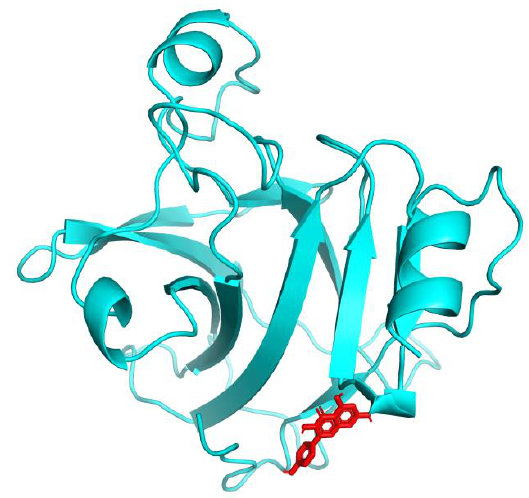
Figure 7. The docking diagram of TP53 and kaempferol.